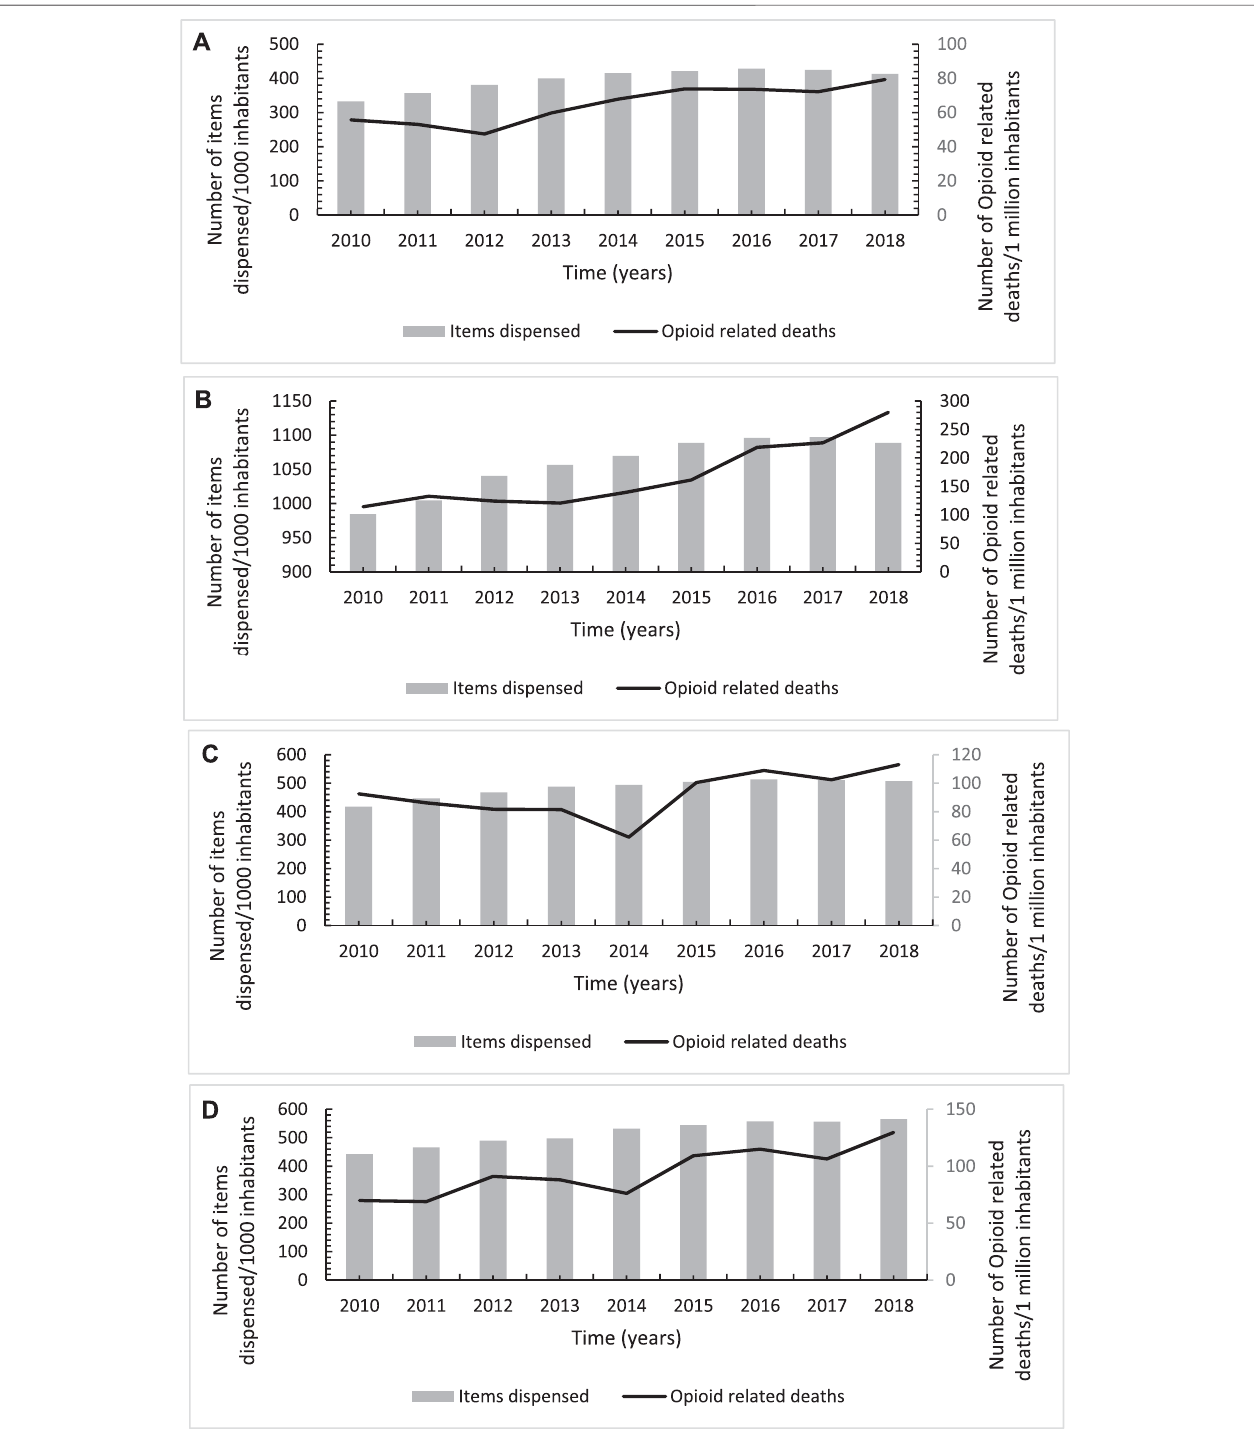
FIGURE6 | Annual trendsin number ofopioids-relateddeaths per one million inhabitants inassociation withits utilisation trends acrossEngland (A) , Scotland (B) , Wales (C) and Northern Ireland (D) over the study period from 2010 to 2018.